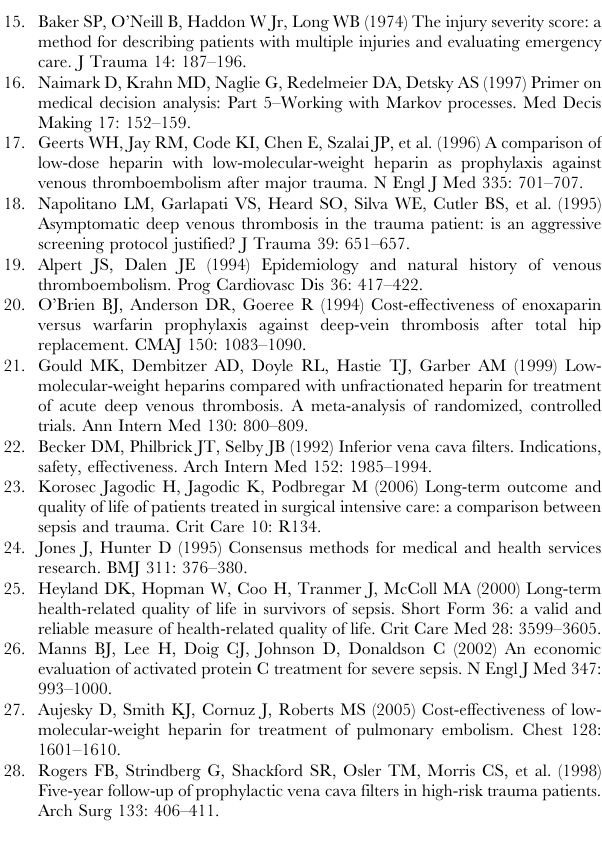
Table S2 Summary of results of included